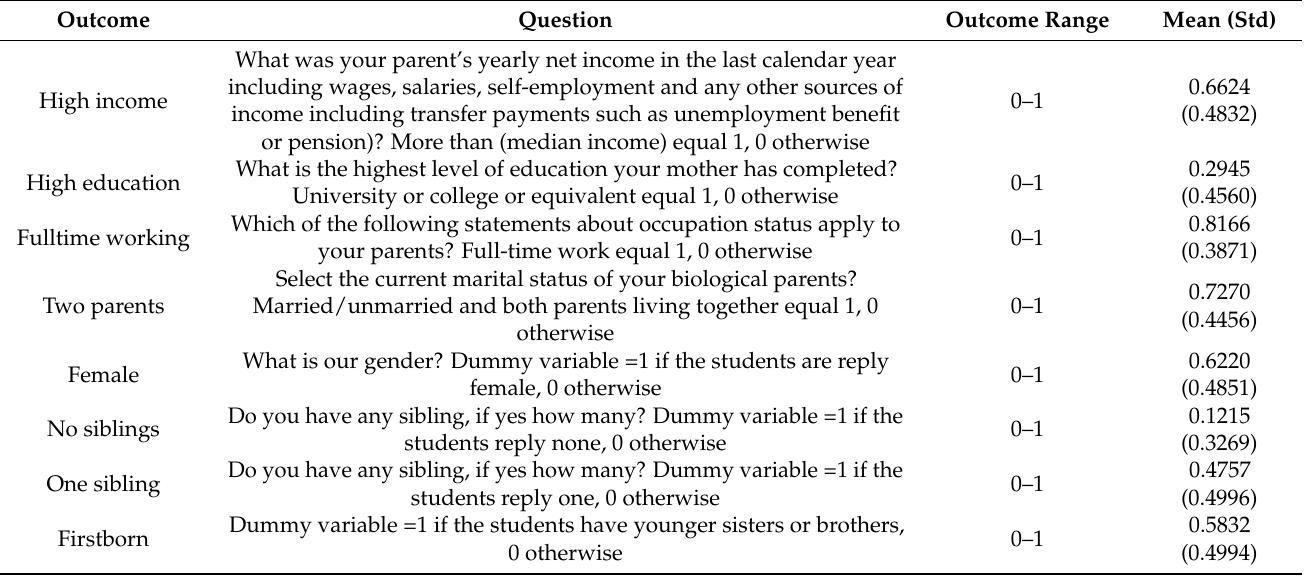
Table 1. Description of sociodemographic characteristics of sample (i)